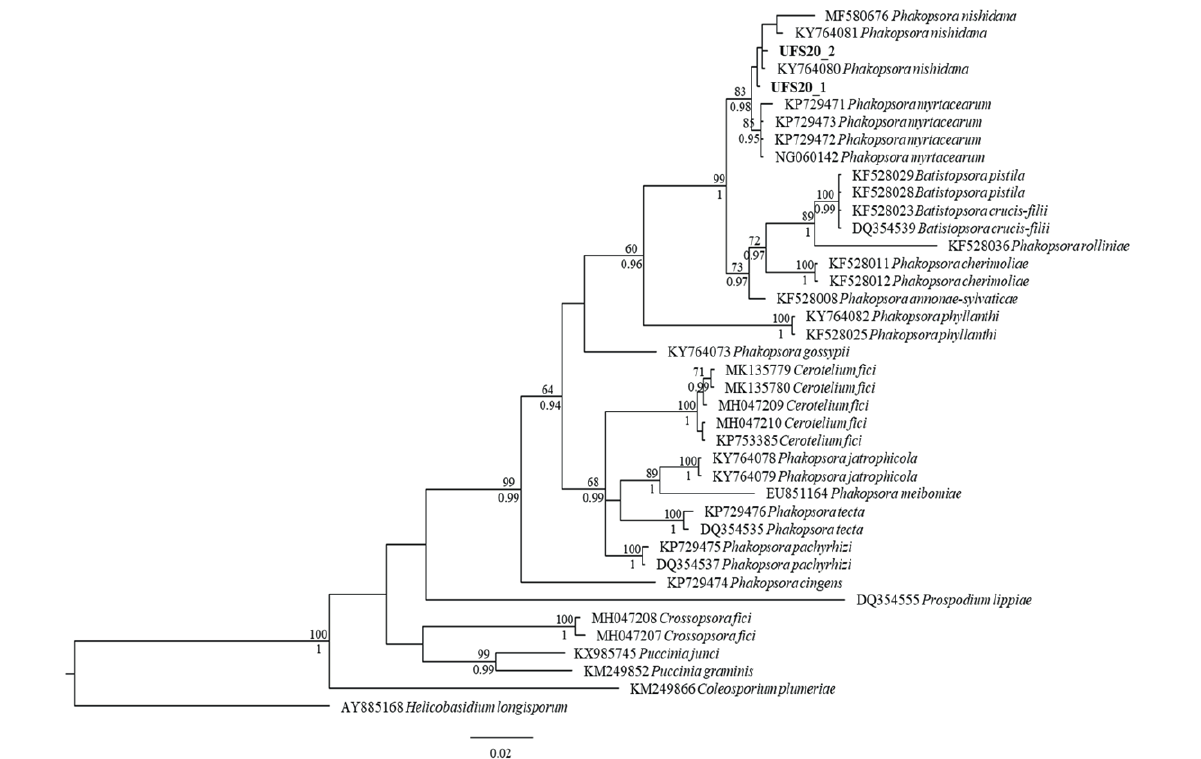
Figure 2. Identification of the Vermont fig rust (isolate PREM63073) using Bayesian inference (BI) and Maximum parsimony (MP) analyses within MrBayes and PAUP*, using the ITS2-28S rRNA locus. The two allelic variants for rust isolate PREM63073 are indicated in bold font. Bootstrap (BS) support values (>60%) are indicated above the nodes, and posterior probability (PP) values (>0.9) are indicated below the